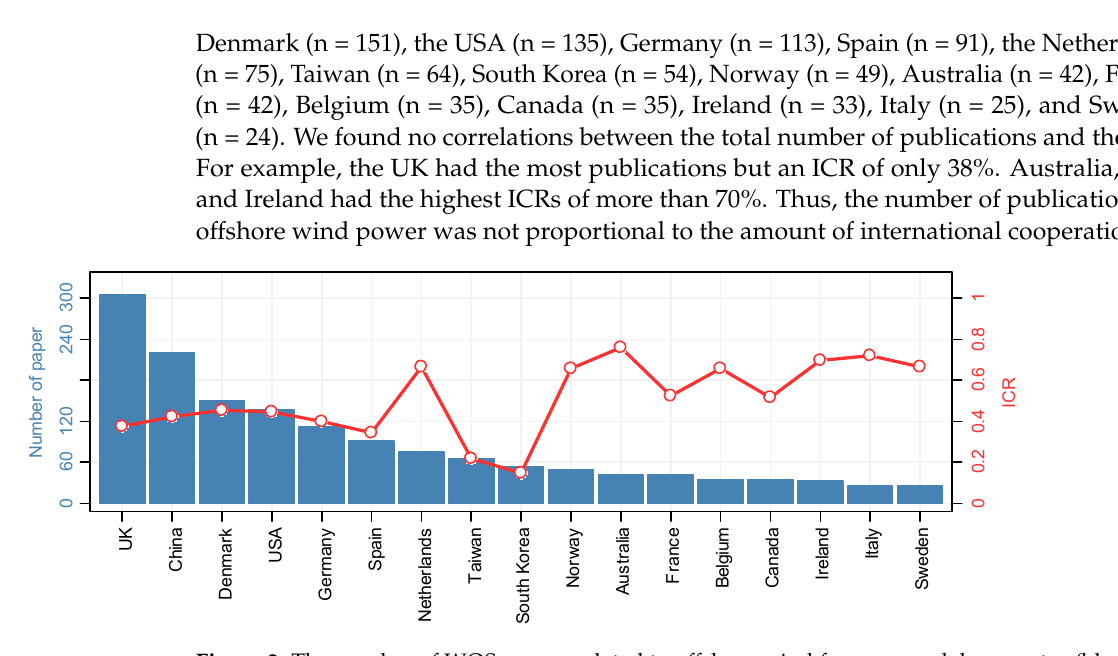
Figure 2. The number of WOS papers related to offshore wind farm research by country (blue bars) and the corresponding international cooperation ratio (ICR) (red line).